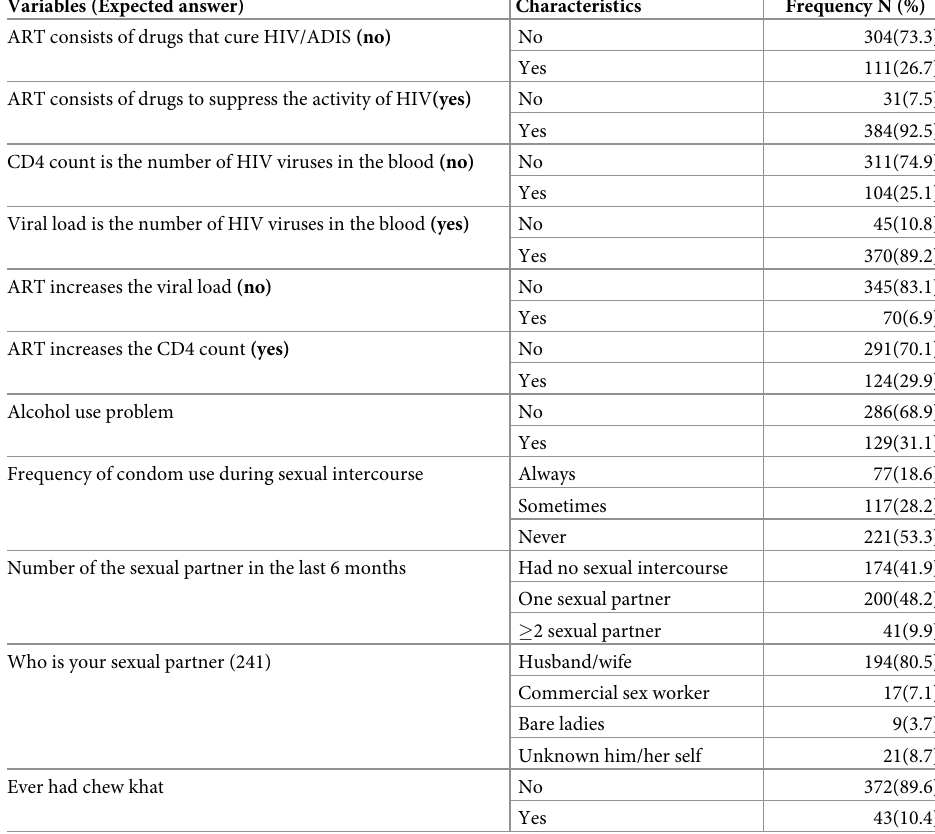
Table 2. Knowledge and risk behaviors related factors of uptake ASM among stable clients on antiretroviral ther- apy in East Gojjam Zone, Amhara, Northwest Ethiopia, 2020 (n = 415). Variables (Expected